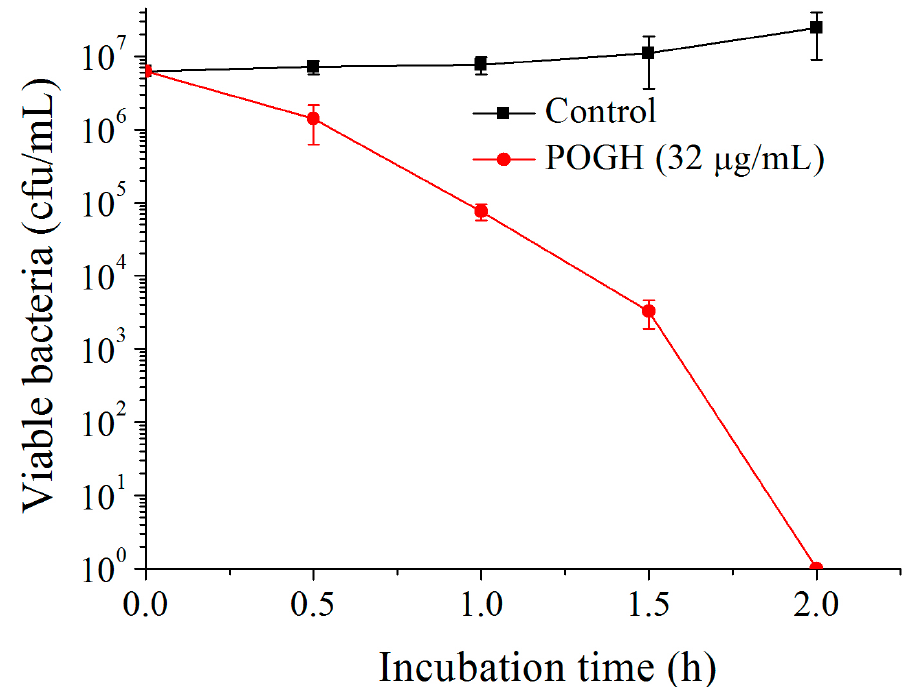
Figure 2. The time-kill curve of polyoctamethylene monoguanidine hydrochloride (POGH) against multidrug-resistant P. aeruginosa . Approximately 6.25 × 10 6 CFU/mL bacterial cells were incubated with 32 μ g/mL POGH at 25 °C for 0.5, 1, 1.5, and 2 h. POGH had a minimum inhibitory concentration of 16 μ g/mL.